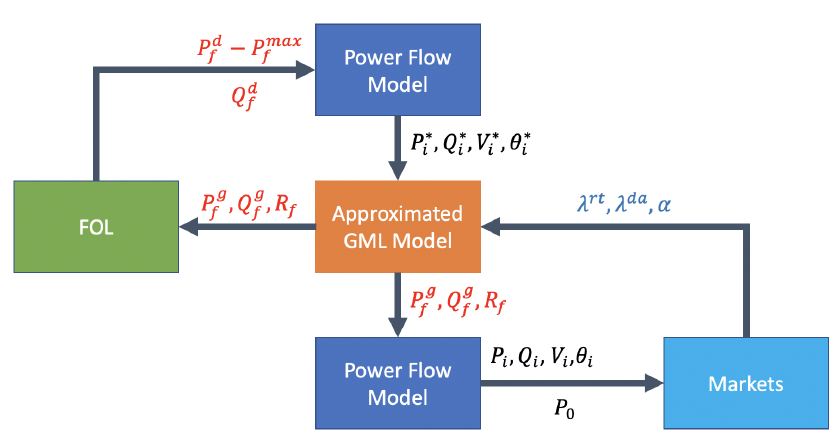
Figure 3. Schematic of the three-layer tuning